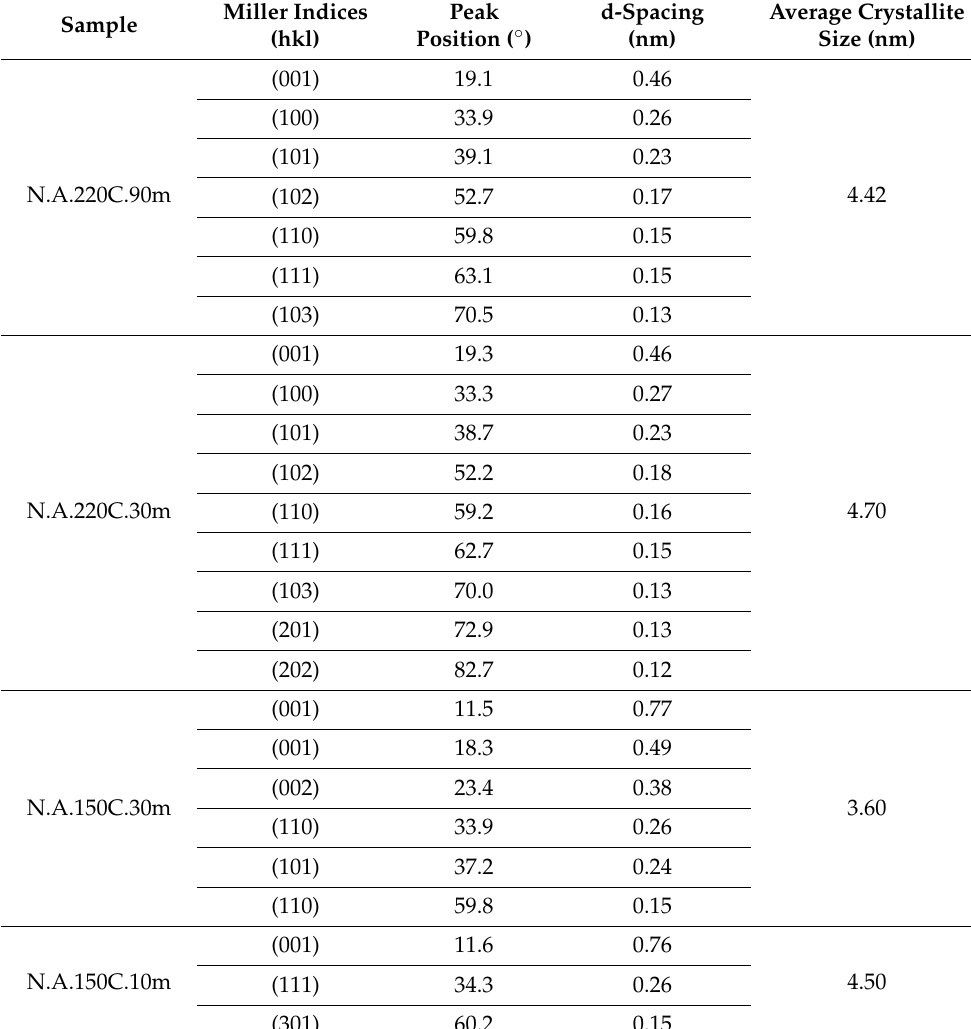
Table 2. The crystallographic structure parameters of Ni(OH) 2